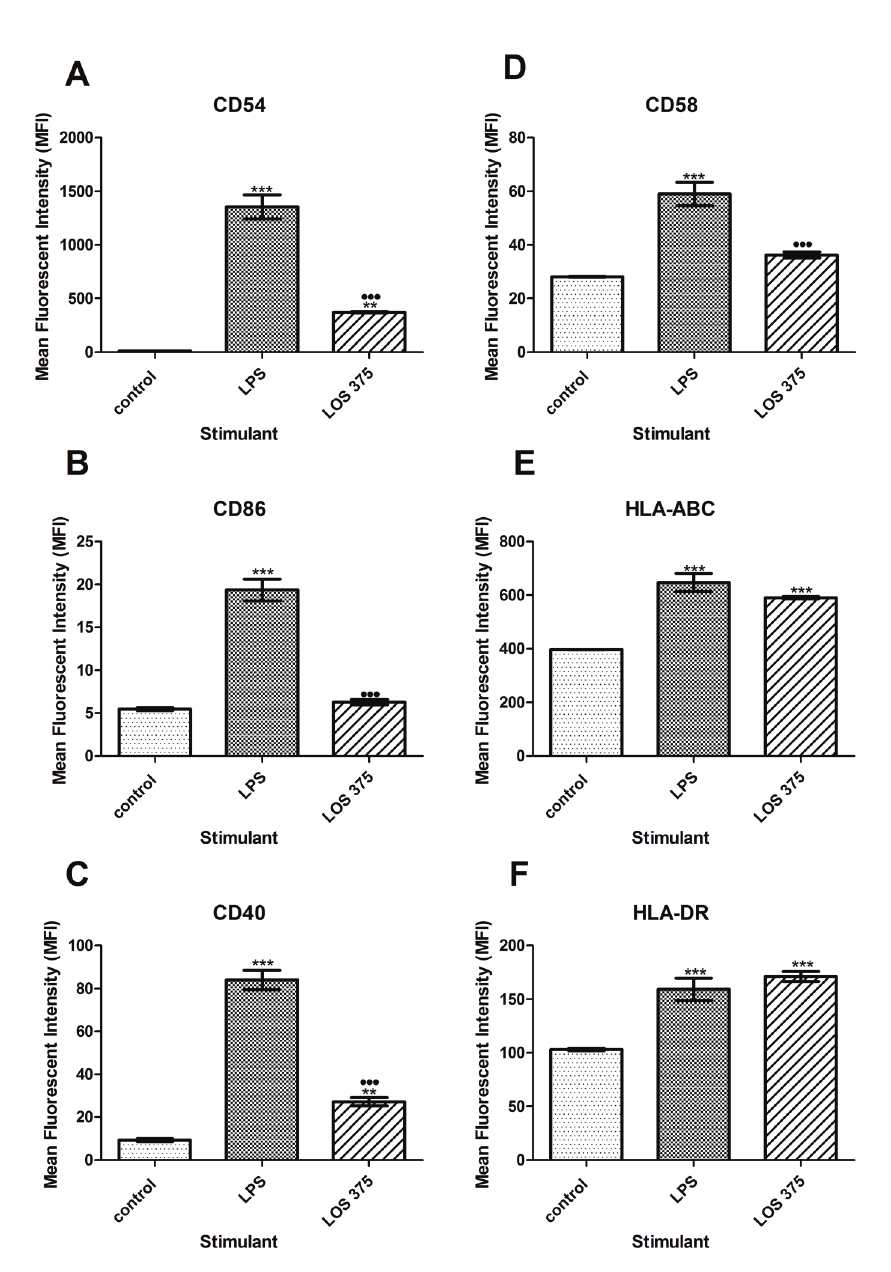
Figure 1. Flow cytometry analysis of the expression of co-stimulatory and antigen-presenting molecules in THP-1 cells stimulated with NTHi LOS or E. coli LPS. THP-1 cells were stimulated with 1.0 µ g/ml of LPS or LOS for 24 hours. Unstimulated THP-1 cells (0.5 × 10 6 ) in complete culture medium served as a negative control. Cell surface expression of CD54 (A), CD86 (B), CD40 (C), CD58 (D) HLA-ABC (E), and HLA- DR (F) was measured and data expressed as the mean fluorescence intensity (MFI); the bars indicate the mean with the standard error of the mean (SEM) (n = 3). *, P < 0.05 compared to the negative control; • , P < 0.05 between LPS and